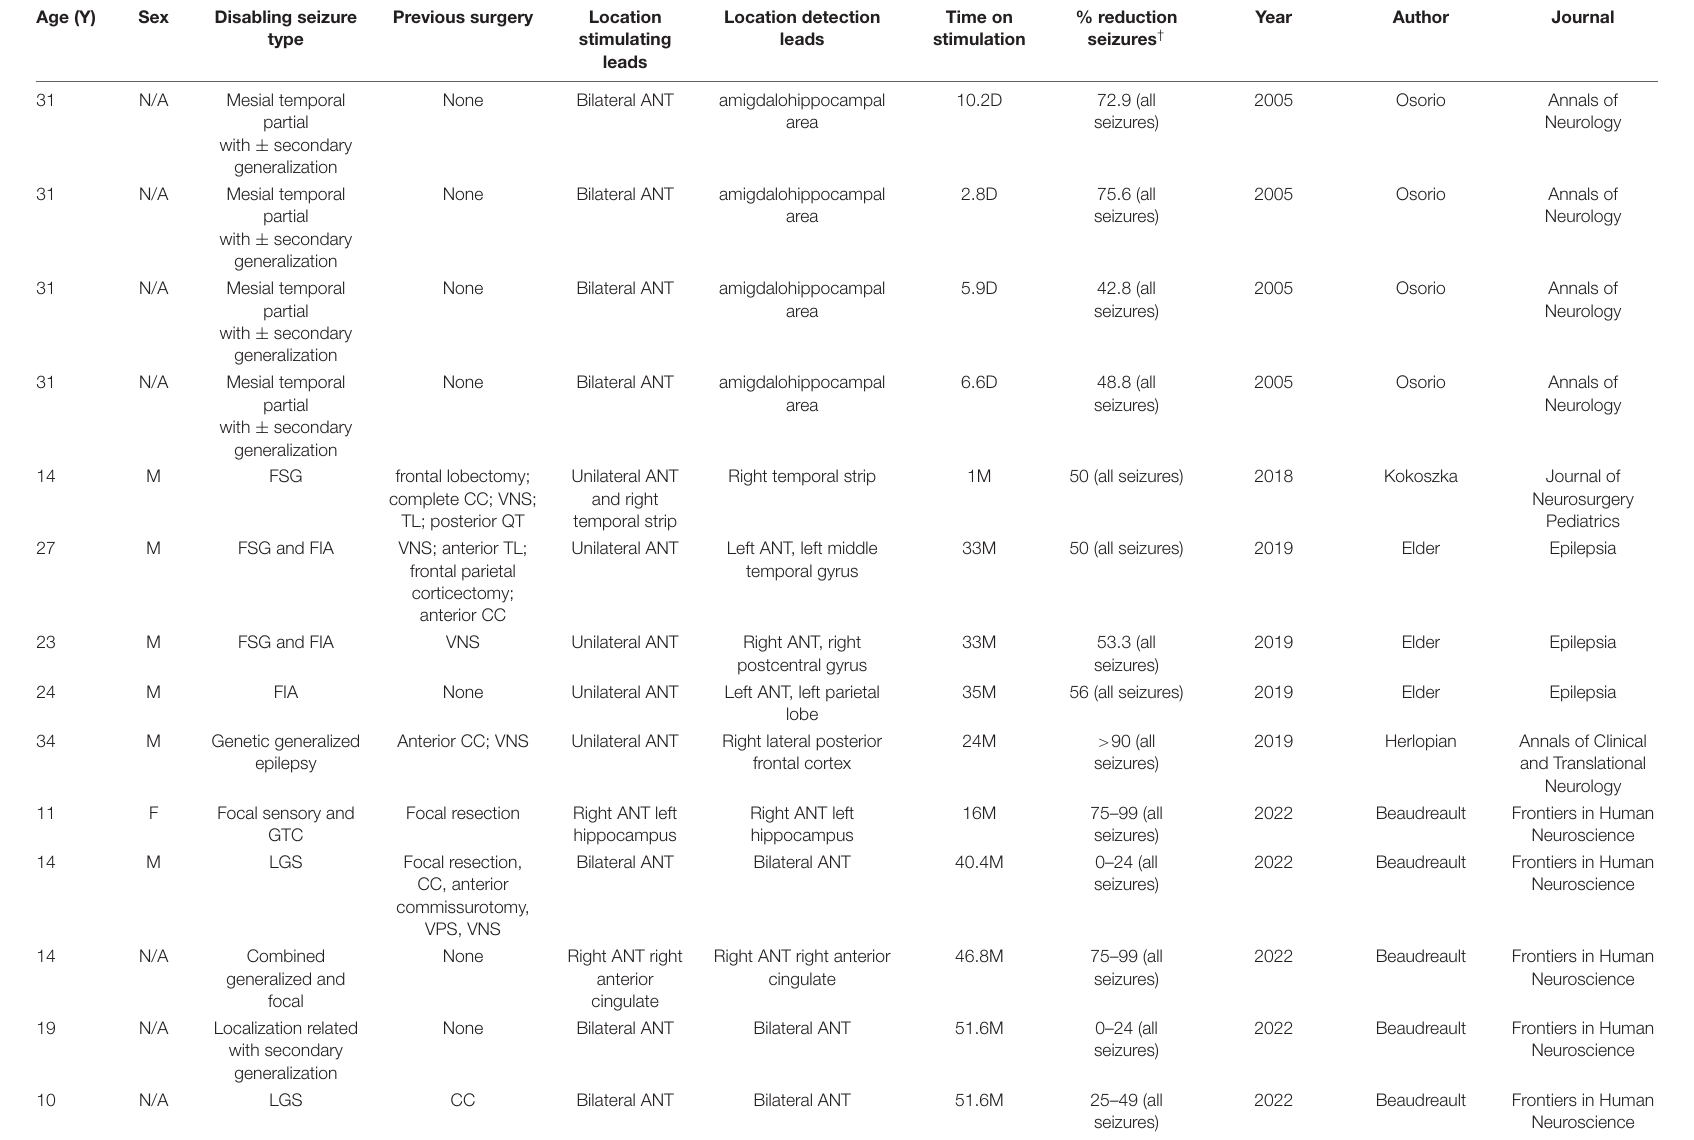
TABLE 1 | Subjects treated with thalamic responsive neurostimulation for refractory epilepsy. Age (Y)